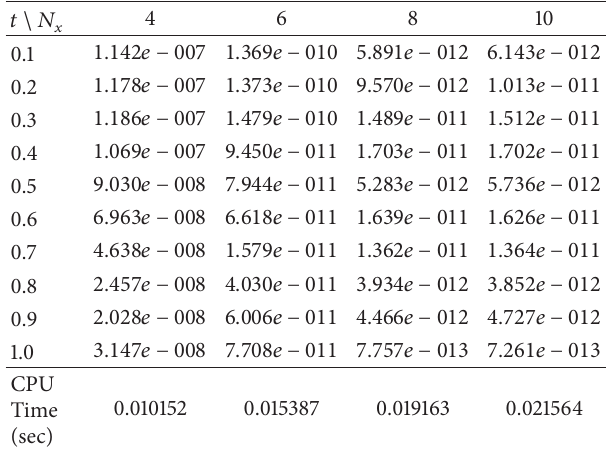
Table 2: Maximum errors 𝐸 𝑁 for the Burgers-Fisher equation when = 10 𝛼 = 𝛾 = 𝛿 = 1 using 𝑁 𝑡